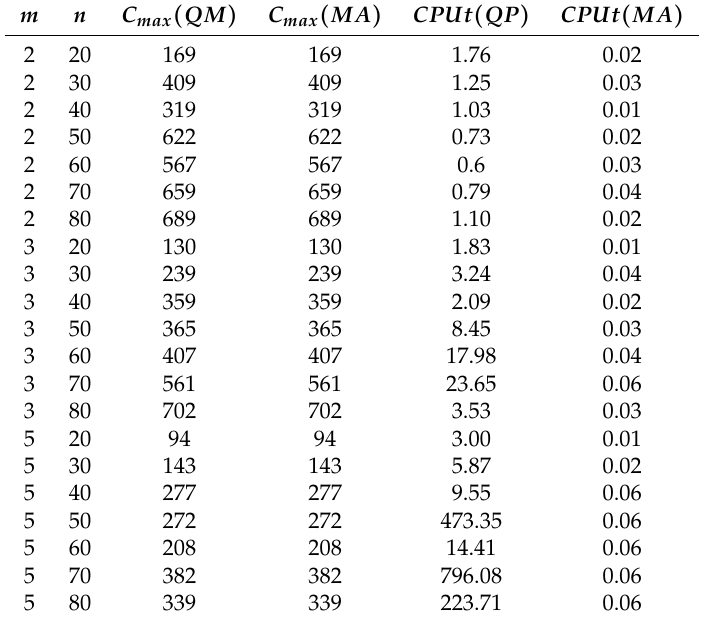
Table 6. Comparison of QM and MA for datasets DS 1 with s i ∈ U ( 1,5 ) and p j ∈ U ( 50,100 )